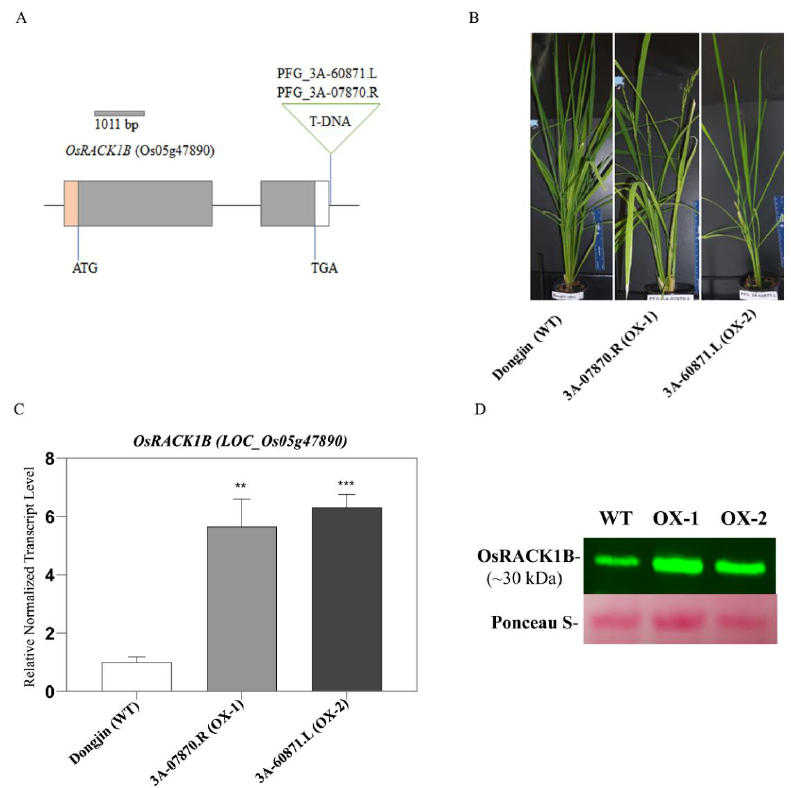
Figure 1. Characterization of T-DNA insertion lines with analysis of gene expression and protein abundance. ( A ) Schematic diagram depicting the positions of T-DNA insertions in OsRACK1B. Gray, orange, and white bars represent the exons, 5´-UTR, and 3´-UTR region, respectively. ATG and TGA are start and stop codons. The 1011 bp indicates the CDS length. The gray line represents the intron. The triangles indicate OsRack1b mutant alleles (OX-1, PFG_3A-07870.R; OX-2, PFG_3A- 60871.L). Plants with T-DNA insertion in 3A-60871.L and 3A-07870.R lines ( B ) resulted in RACK1B overexpression, revealed by expression analysis shown in qRT-PCR ( C ) and Western blot ( D ). Samples were collected from four-week-old wild-type (WT) and OsRack1b mutant rice plants. For Western blot, an equal amount of leaf proteins extracted from the indicated genotypes was